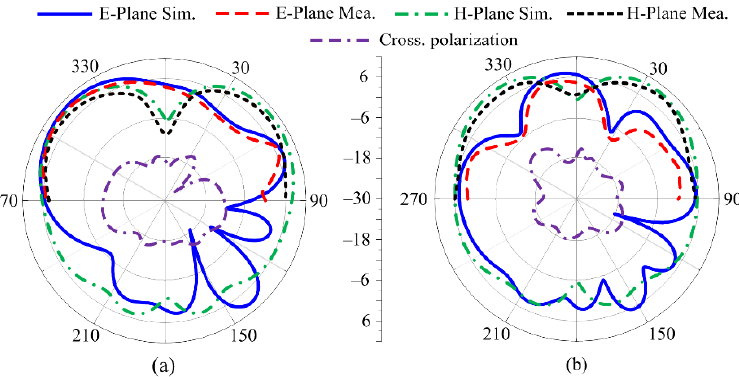
Figure 12. Radiation pattern and cross polarization of proposed MIMO antenna at ( a ) 28 GHz and ( b ) 38 GHz.